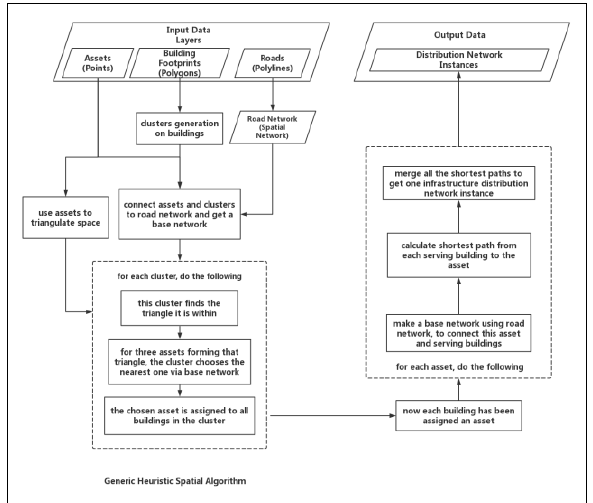
Figure 2. Implementation of generic heuristic spatial algorithm.